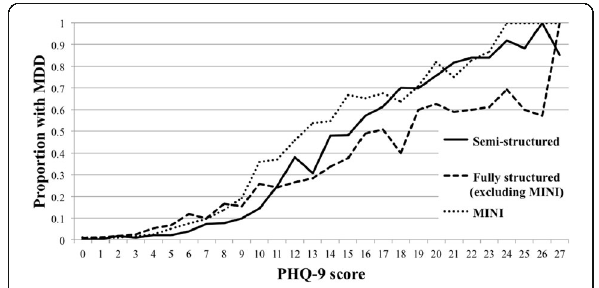
Fig. 1 (abstract P41). Probability of MDD diagnosis across depressive symptom levels for different diagnostic interview